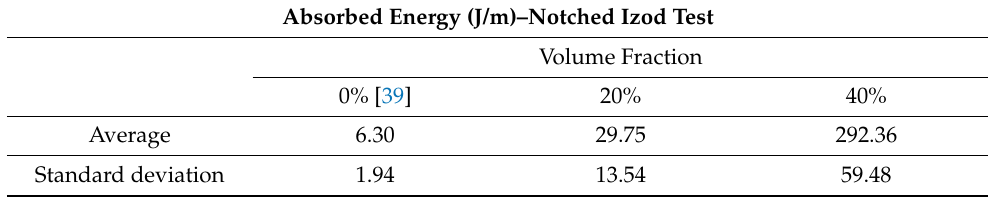
Table 3. Results of the Izod impact test for epoxy composites reinforced with arapaima